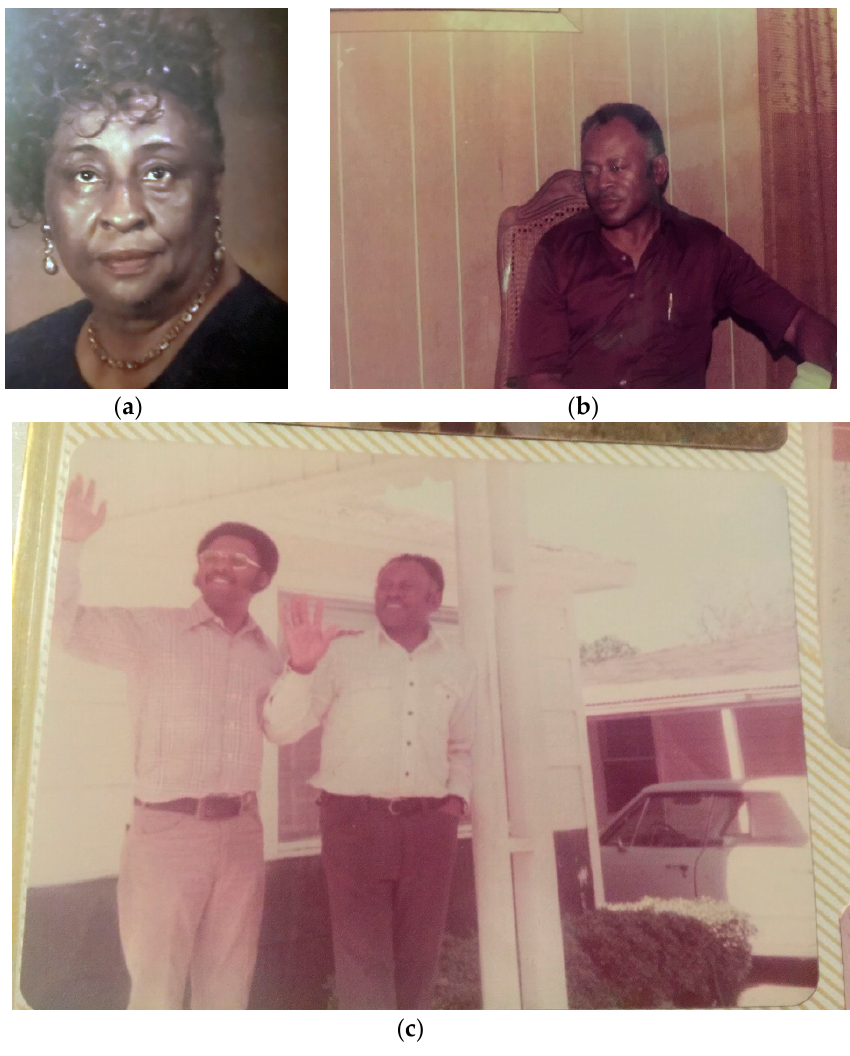
Figure 9. ( a ) Emmola Taylor Frazier; ( b ) Albert Frazier, Jr.; ( c ) Winfred Frazier with Albert Frazier, Jr. in front of their Fifth Ward home. Photographs courtesy of the Frazier family.